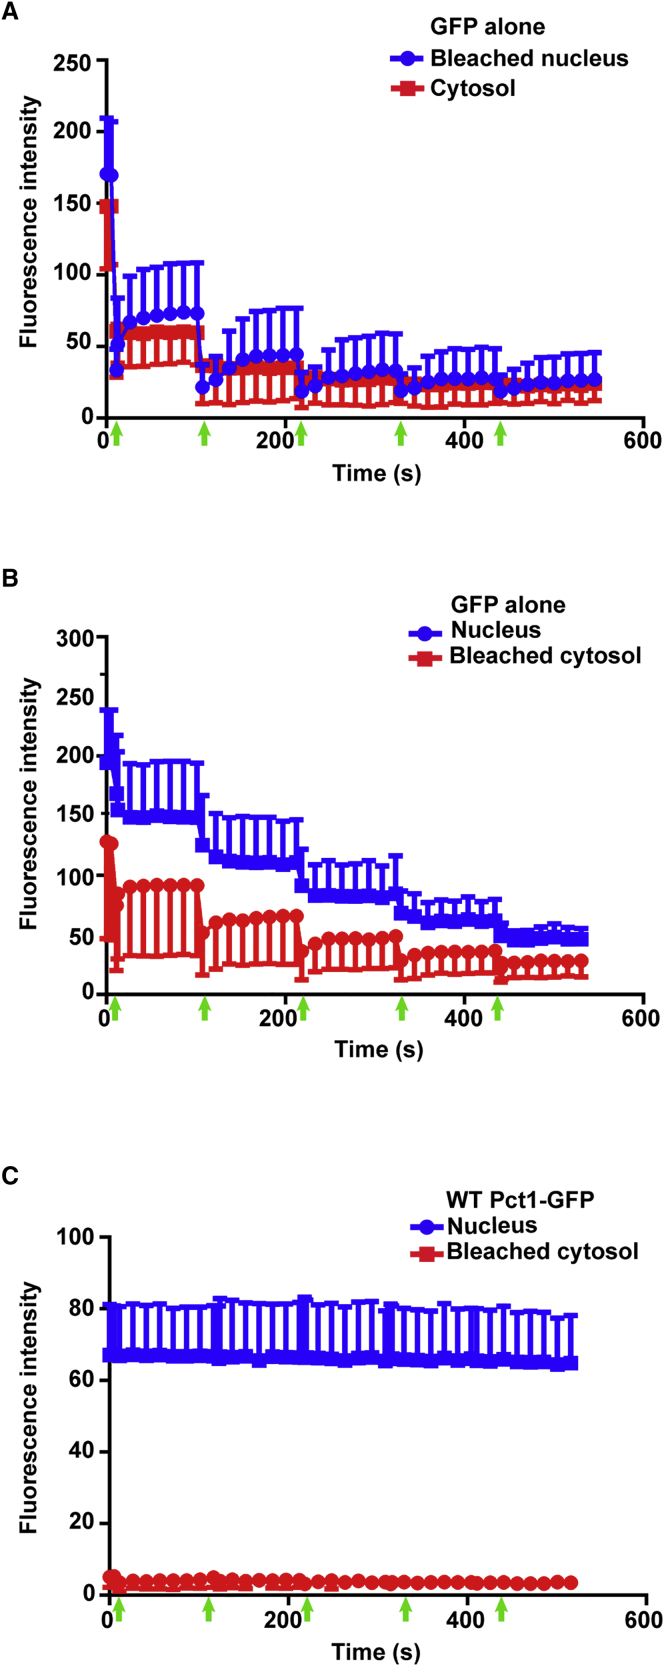
Pct1-GFP Is Confined to the Nucleus in Yeast Cells(A and B) In WT (BY4742) yeast cells expressing GFP alone, repeated photobleaching of GFP in the nucleus (A) or cytosol (B) is rapidly followed by partial recovery of the fluorescence in the photobleached regions, with a concomitant progressive loss of fluorescence in the unbleached regions, indicating rapid movement of GFP between these two cellular compartments.(C) In pct1Δ cells expressing WT Pct1-GFP, repeated photobleaching of the signal in the cytosol does not result in a loss of fluorescence of WT Pct1-GFP within the nucleus, indicating little or no rapid shuttling of Pct1-GFP from the nucleus to the cytosol. Data are means ± SD from three independent experiments (five to eight cells each). Arrows on the x axes indicate each bleaching event.